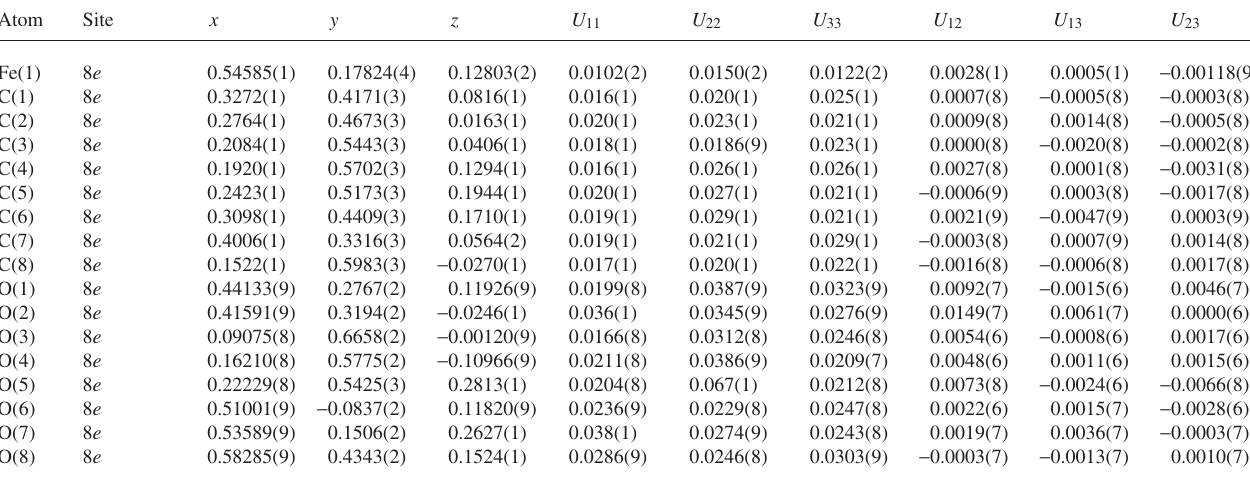
Table 3. Atomic coordinates and displacement parameters (in Å 2 )